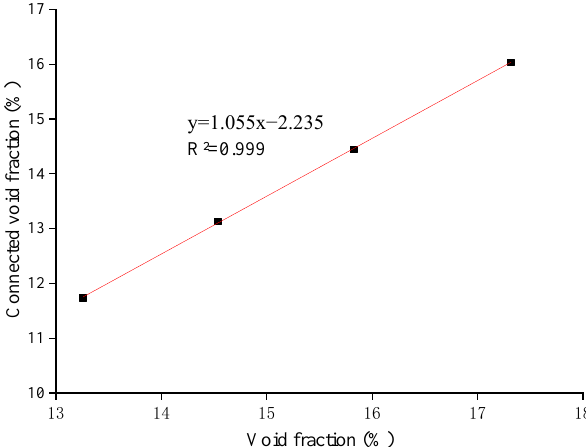
Figure 9. EPA-13 void fraction and connected void fraction fitting curve.